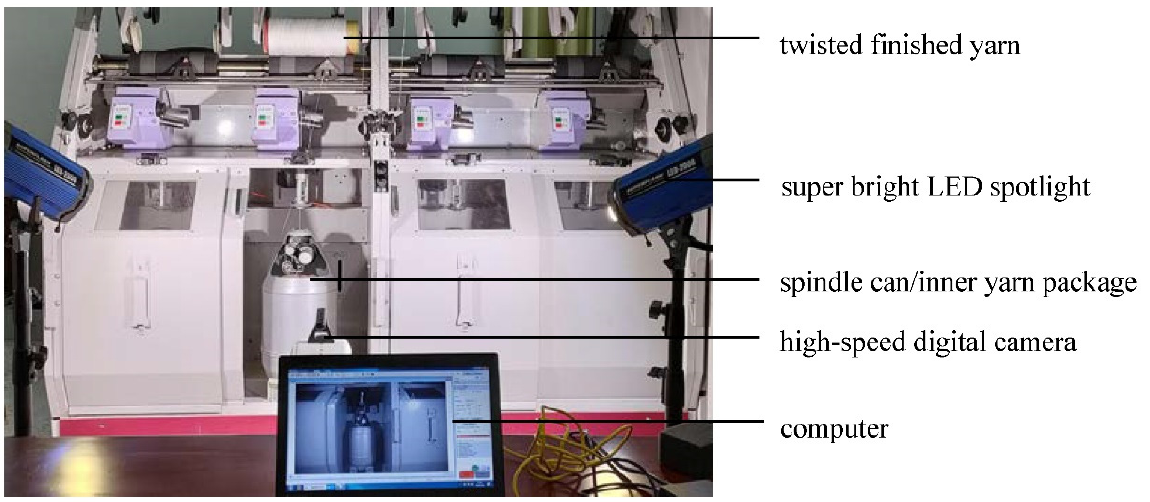
Figure 2. Experimental equipment for the direct-twisting machine.